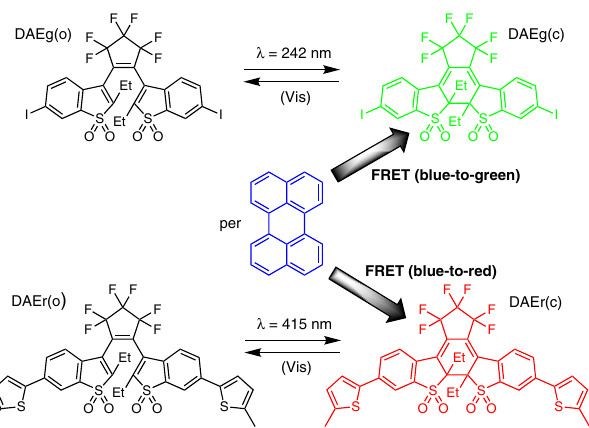
Fig. 1 Structures and isomerization scheme of the compounds used in this study. The shaded arrows indicate the FRET (Förster Resonance Energy Transfer) processes and the accompanying changes in the emission color.